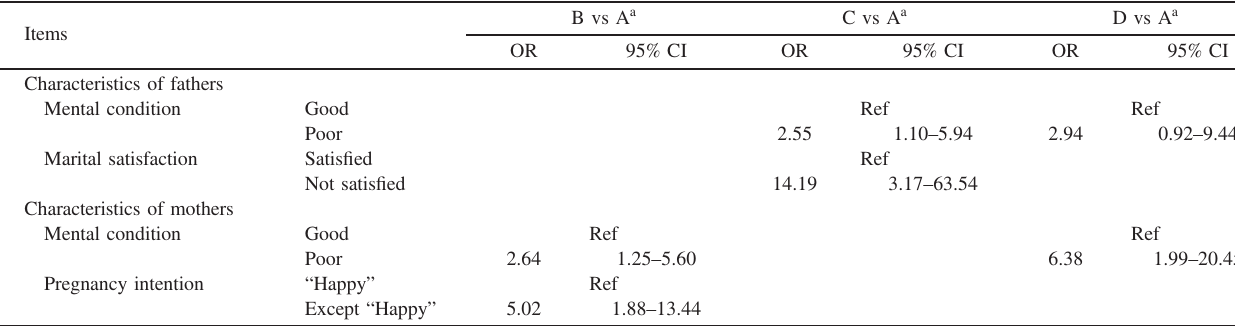
Table 5. Multivariable analysis of characteristics of